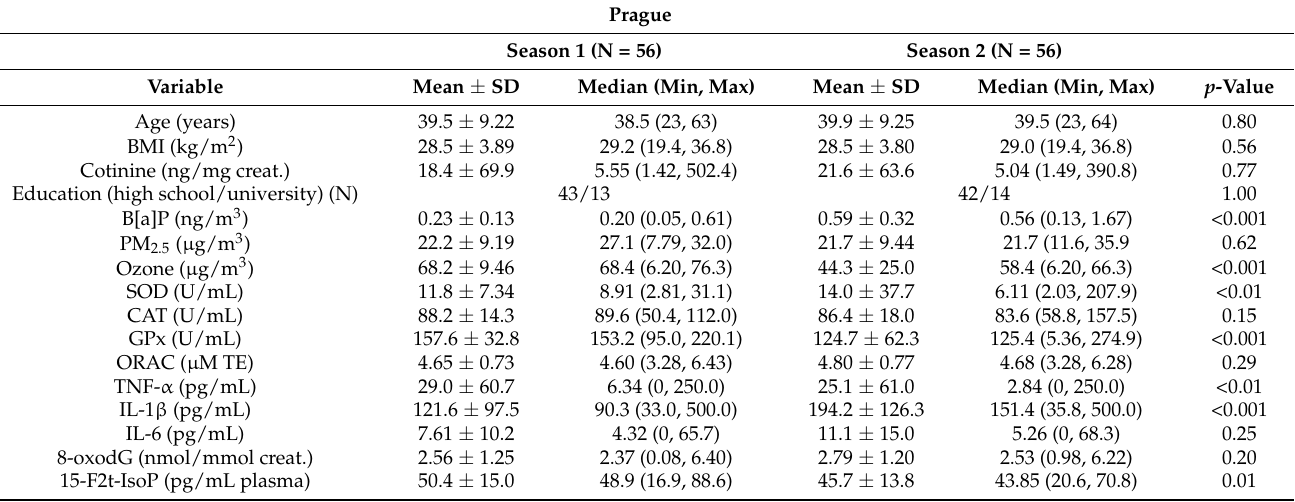
Table 2. Characteristics of the study population, exposure to environmental pollutants, pa- rameters of antioxidant and immune response, and oxidative stress markers: locality Prague; SD–standard